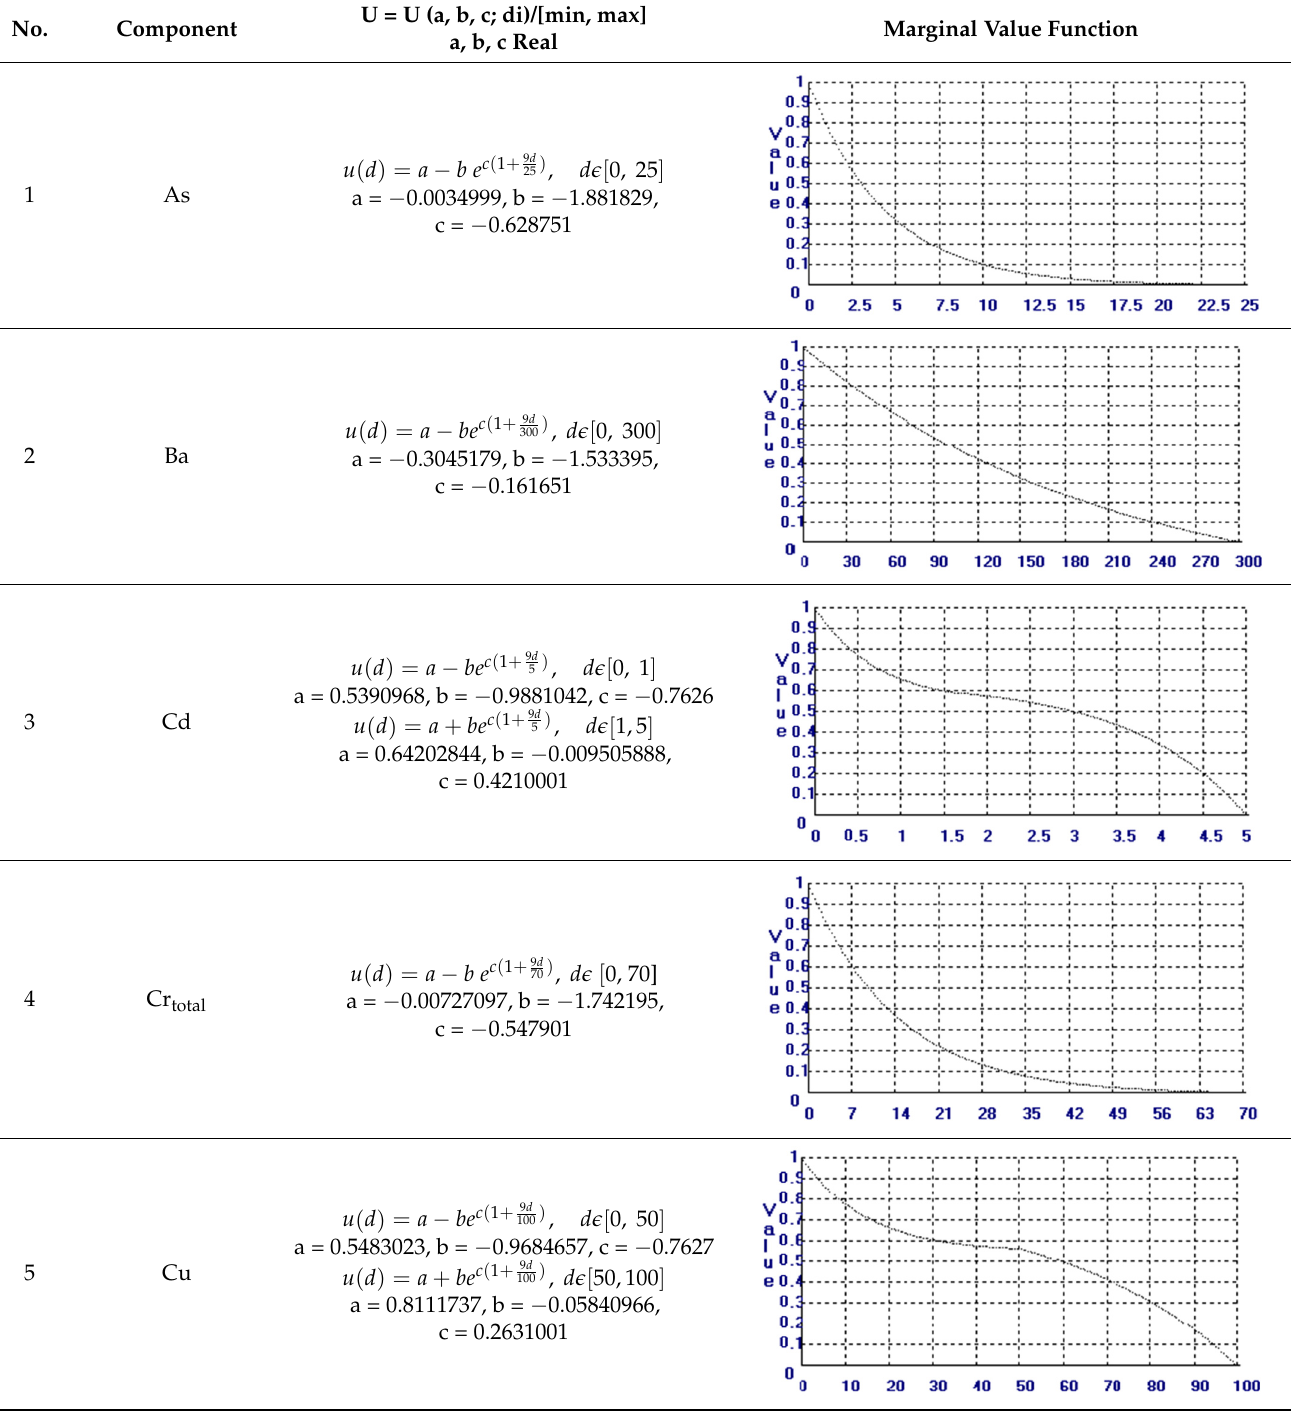
Table 3. Marginal value functions for the 15 examined components—screen layouts of the MIIDAS system.